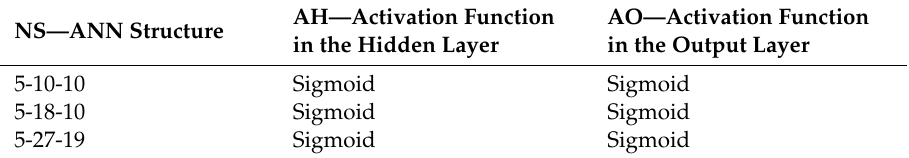
Table 2. The best multi-layer perceptron (MLP) network models for diagnostic measures. NS—ANN